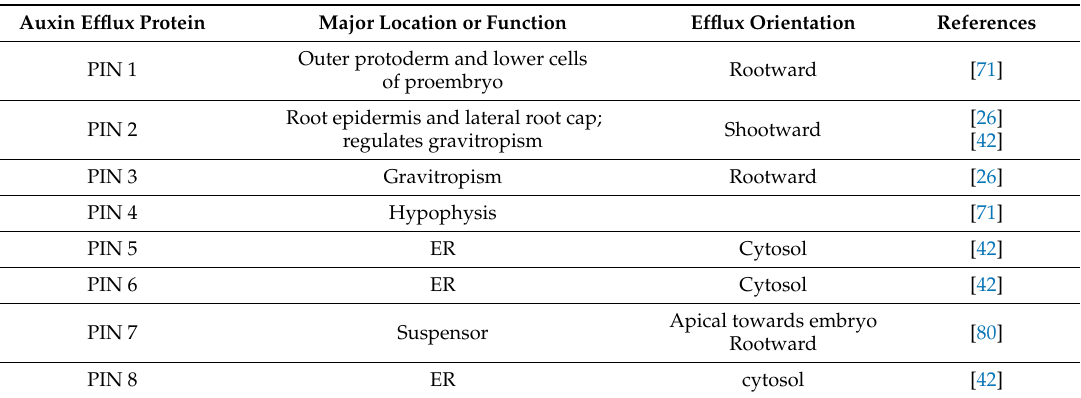
Table 2. The PIN Ffamily of auxin efflux